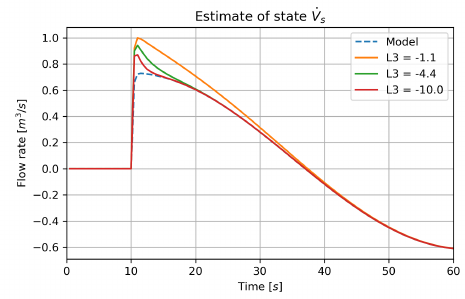
Figure 5: Observer behavior when only measurement x 3 is injected. Gain L 3 is varied to study its effect on convergence.